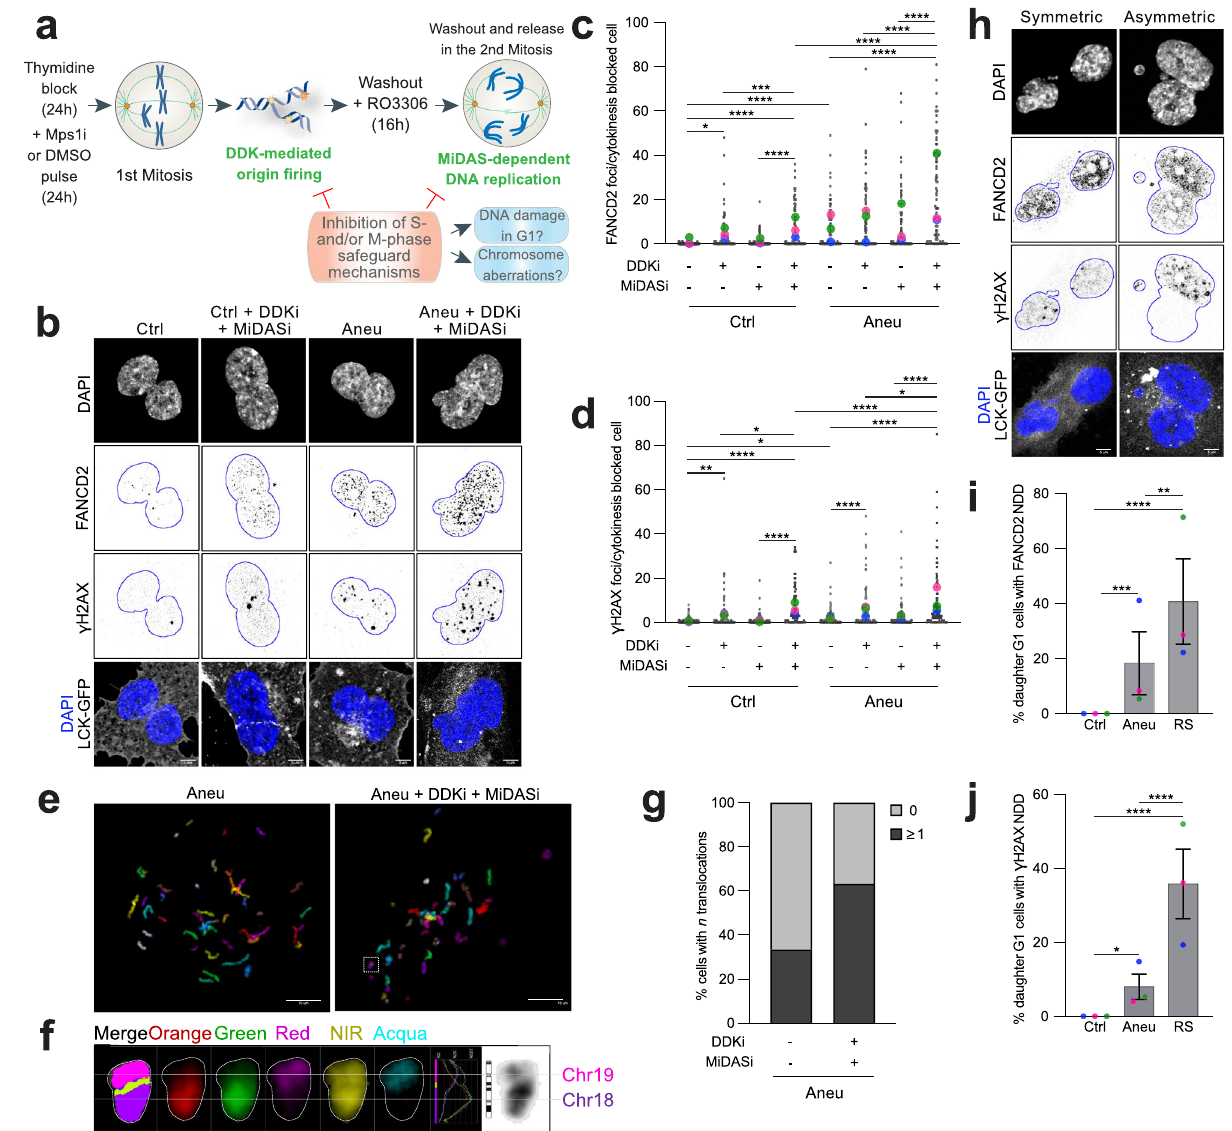
Fig. 4 | DDK and MiDAS act as surveillance mechanisms to limit genome instability accumulation in aneuploid cells. a Experimental work fl ow for the analysis of DNA damage and chromosome aberrations in G1 cells following DDK andMiDASinhibitioninthecellcycleafterchromosomemissegregationinduction. Representative images ( b ) and quanti fi cation of FANCD2 ( c ) and γ H2AX ( d ) accu- mulationin cytokinesis-blocked pseudo-G1 cells expressing LCK-GFP(forFANCD2: n =90 for Ctrl, n =72 for Ctrl+DDKi; n =84 for Ctrl+MiDASi, n =81 for Ctrl+DDKi +MiDASi; n =87forAneu, n =88forAneu+DDKi, n =90forAneu+MiDASi, n =86for Aneu+DDKi+MiDASi.For γ H2AX: n =90forCtrl, n =72forCtrl+DDKi; n =84forCtrl +MiDASi, n =81 for Ctrl+DDKi+MiDASi; n =88 for Aneu, n =93 for Aneu+DDKi, n =95 for Aneu+MiDASi, n =90 for Aneu+DDKi+MiDASi.). In ( c ), * indicates p =0,0113, *** indicates p =0.0003 and **** indicates p <0,0001. In ( d ), * indicates p =0,0122 (Ctrl vs Aneu) or p =0.0152 (Ctrl+DDKi vs Ctrl+DDKi+MiDASi) or p =0.0242 (Aneu+DDKi vs Aneu+DDKi+MiDASi); ** indicates p =0.0055 and **** indicates p <0,0001. e RepresentativemFISHimagesofG1cell-derivedmetaphase- likechromosomesfromaneuploidcellsuponDDKandMiDASinhibition. f Zoomed image of the chromosome highlighted in the dotted-line box in ( e ) (image on the right)fromtheaneuploidsampleinwhichDDKandMiDASwereinhibitedshowing a translocation between chromosome 19 and chromosome 18. g Quanti fi cation of thepercentageofcellswithmorethan1translocationinthetwosamples( n =18for